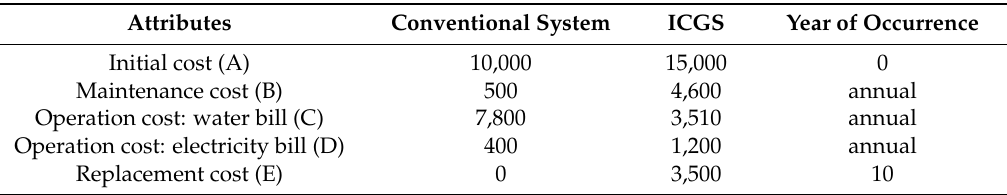
Table 1. Life-cycle cost of conventional system and